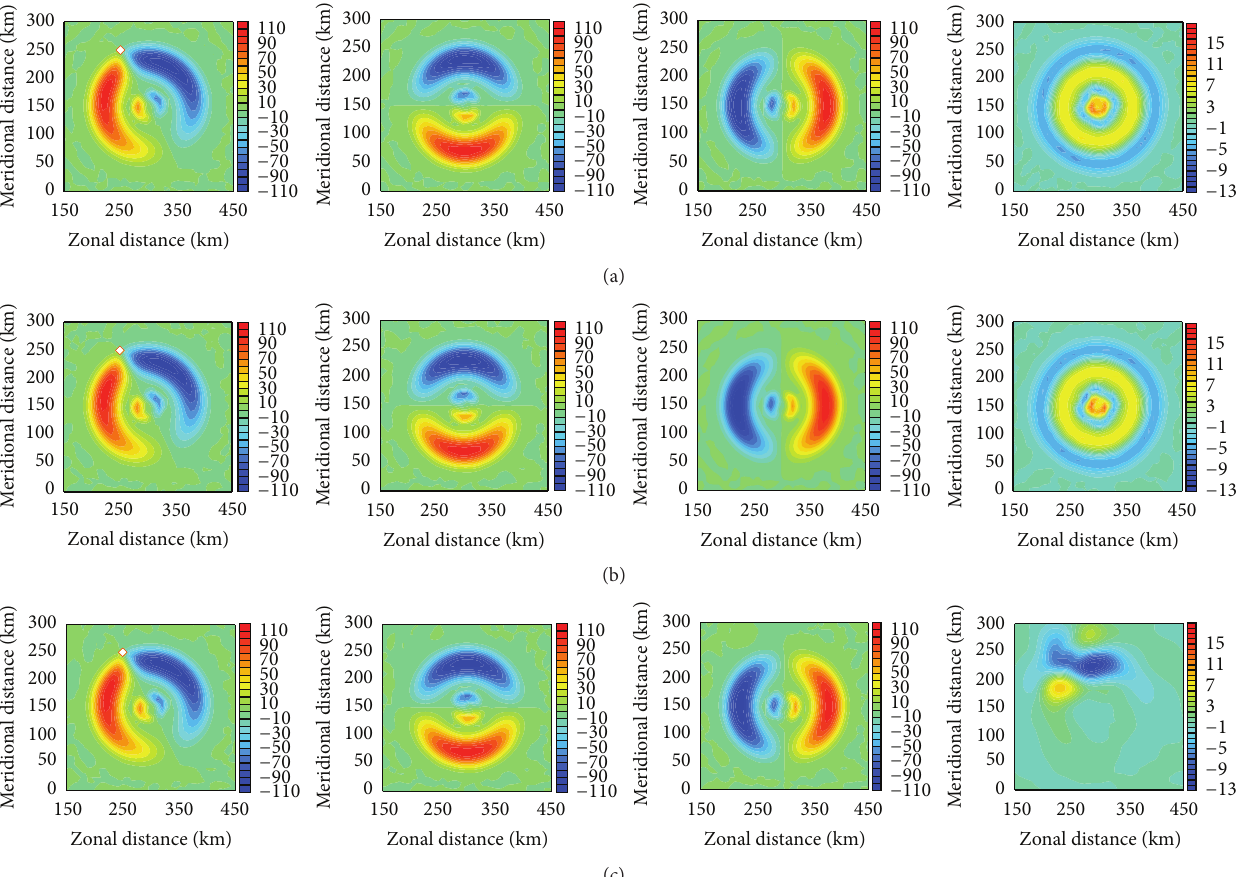
Figure 4: (a) and (b) are similar to Figures 2(b) and 2(c) but with the conventional data substituted by dense conventional data. (c) is similar to (b) but with weak constraint (unit: